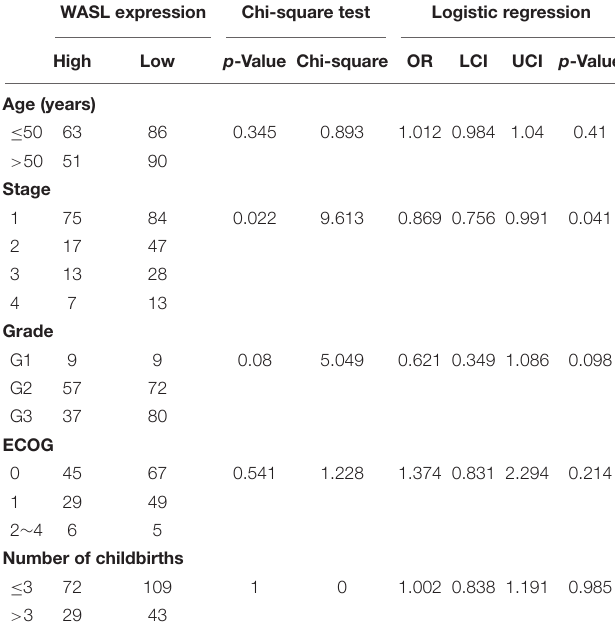
TABLE 1 | The associations between the expression of WAS expression and clinical characteristic of patients with cervical cancer in TCGA-CESC. WASL